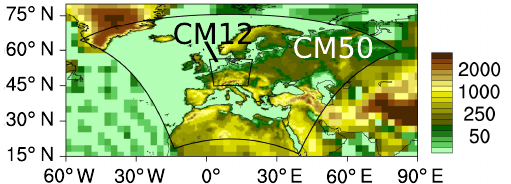
Figure 1. Computational domain of the CM50 and CM12 instances. Depicted is the topography (in metres) in the resolution of the corre- sponding instance. Outside, the CM50 domain the values of EMAC are displayed. In both cases, the whole computational domains, in- cluding the boundary zones, are shown.